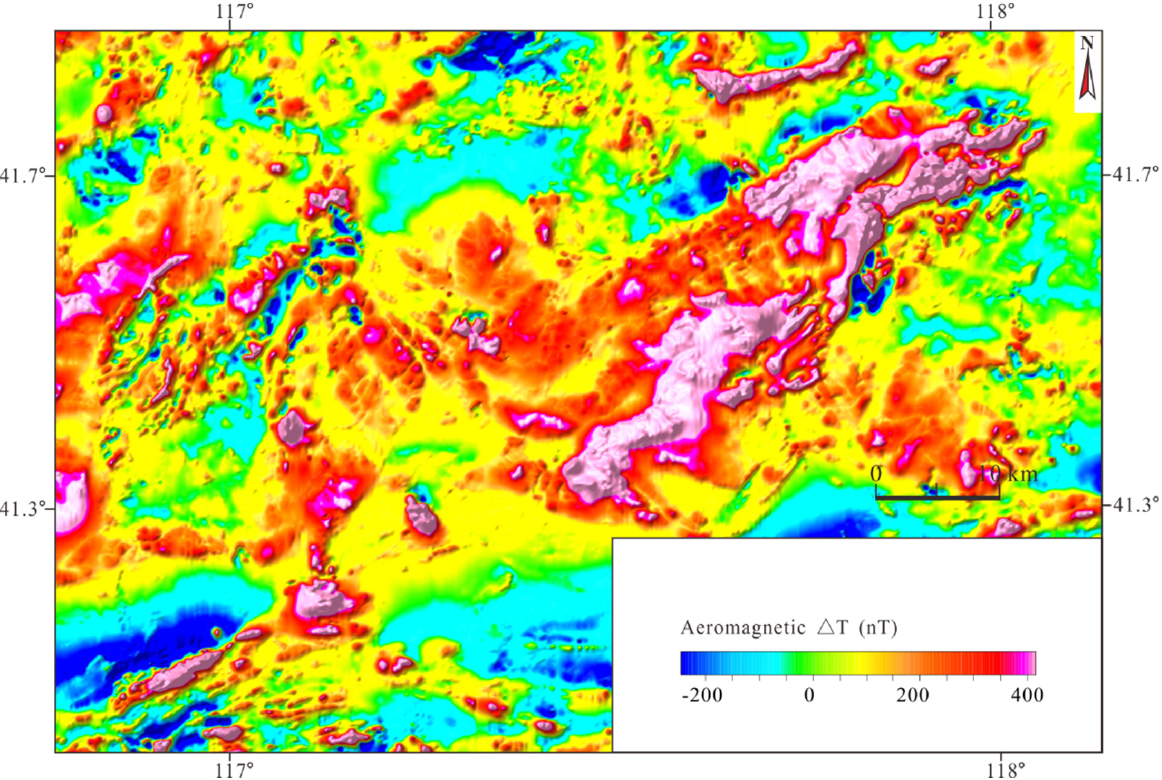
Figure 2. Aeromagnetic ∆ T of the study region.